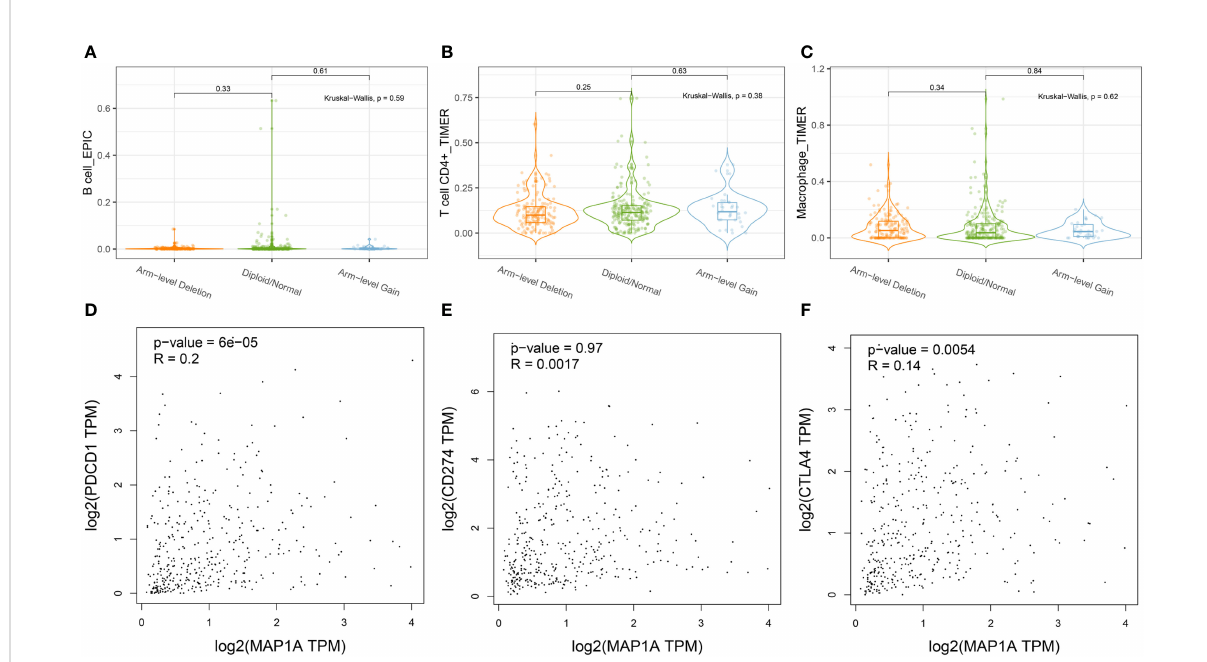
FIGURE 7 Correlation of MAP1A arm-level deletion with immune cells: (A) B cell; (B) CD4+ T cell; (C) Macrophage. MAP1A correlation analysis with immune checkpoint genes was analyzed by the database GEPIA: (D) PDCD1; (E) CD274; (F)